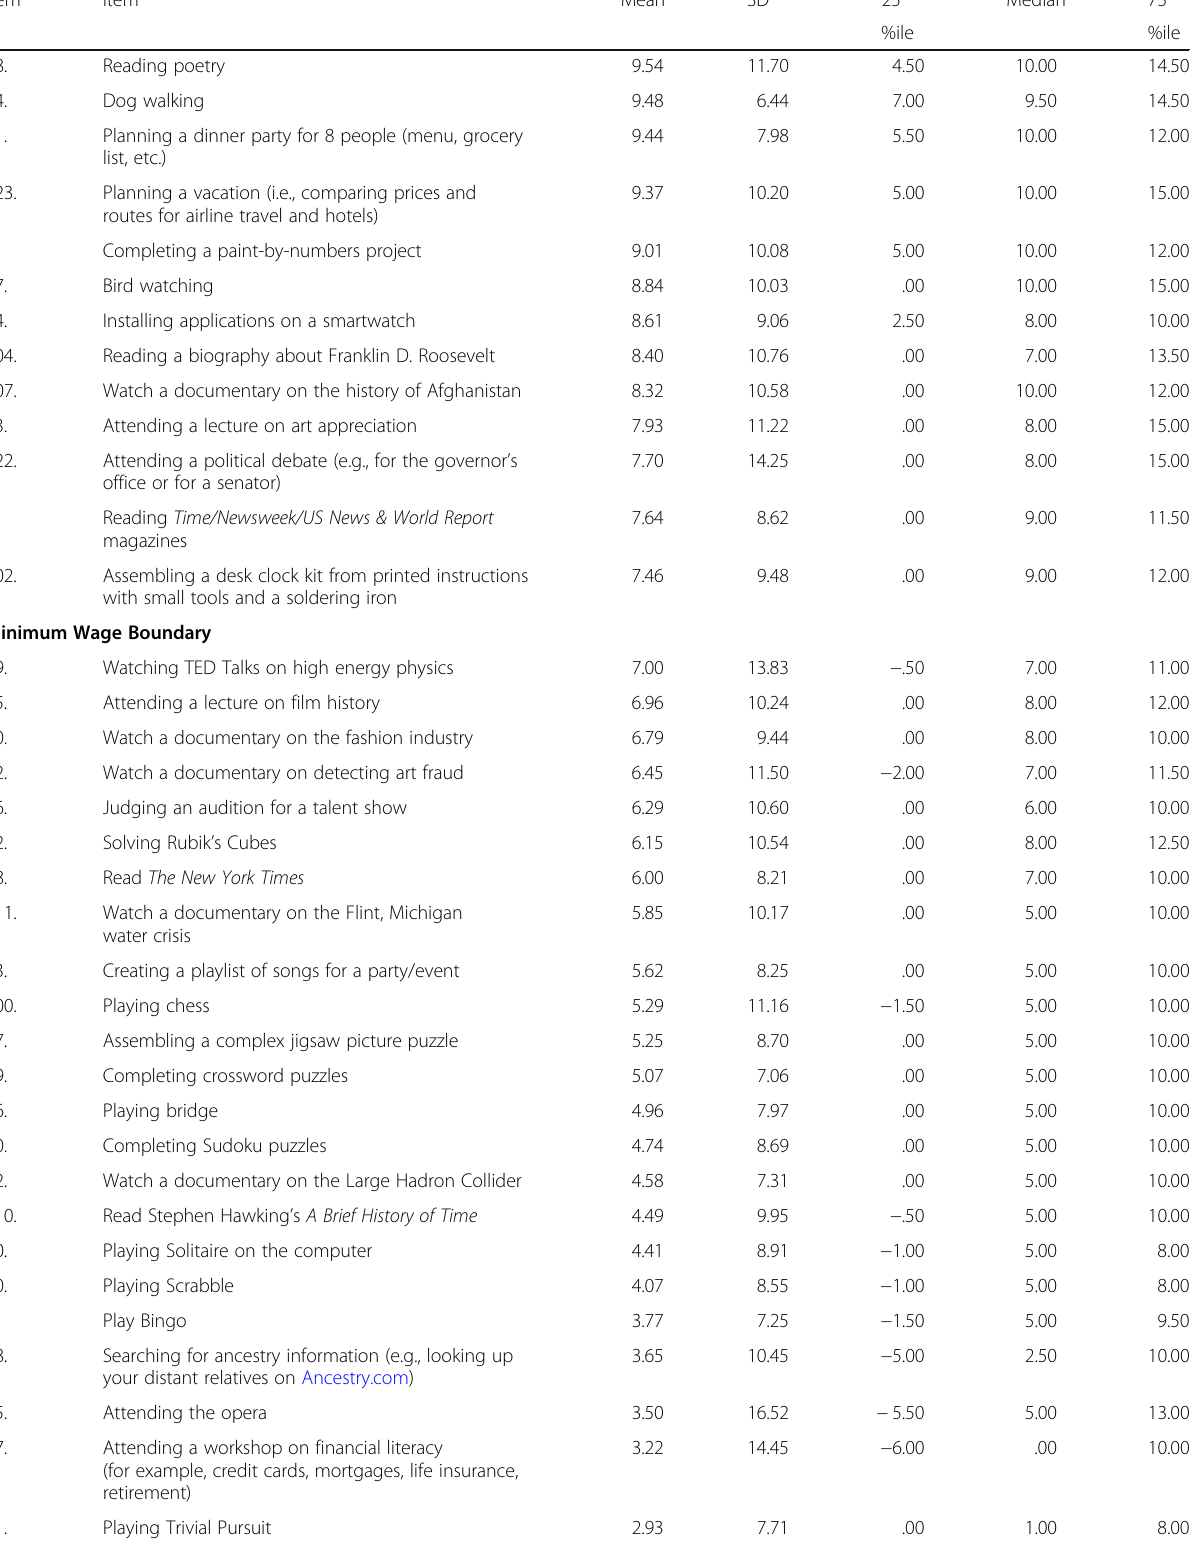
Table 1 Disutility judgments. Task items and descriptive statistics (mean, SD, 25%ile, median, 75%ile)